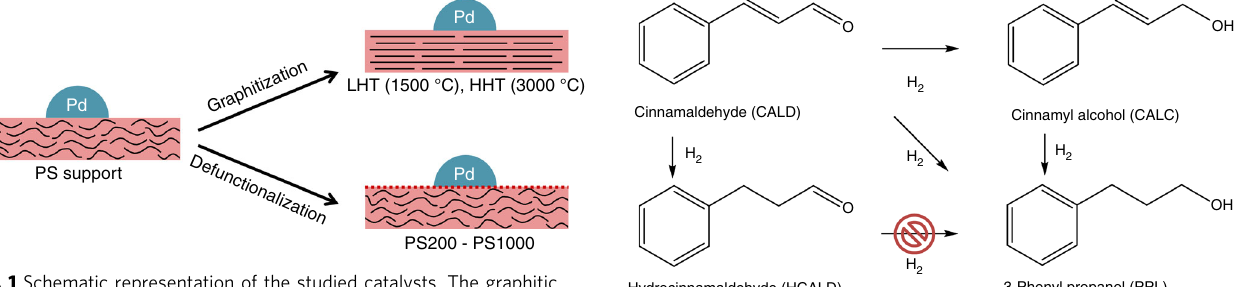
97%) carbon balance (Supplementary Tables 2 and